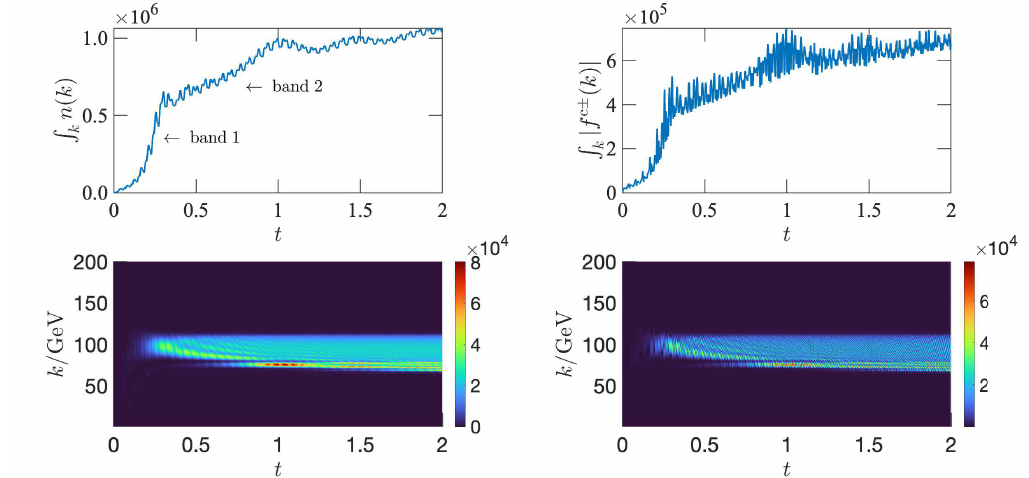
Figure 5 . Shown is the evolution of the integrated number density (top left) and the absolute value of the integrated coherence function same parameters as in figure 4. The bottom row shows the heat plots in the momentum and time variables for the unintegrated distributions multiplied by the phase space factors: k 2 (cid:12) (cid:12) left) and k 2 (cid:12) (lower (cid:12) f c ± k 2 (cid:25) 2